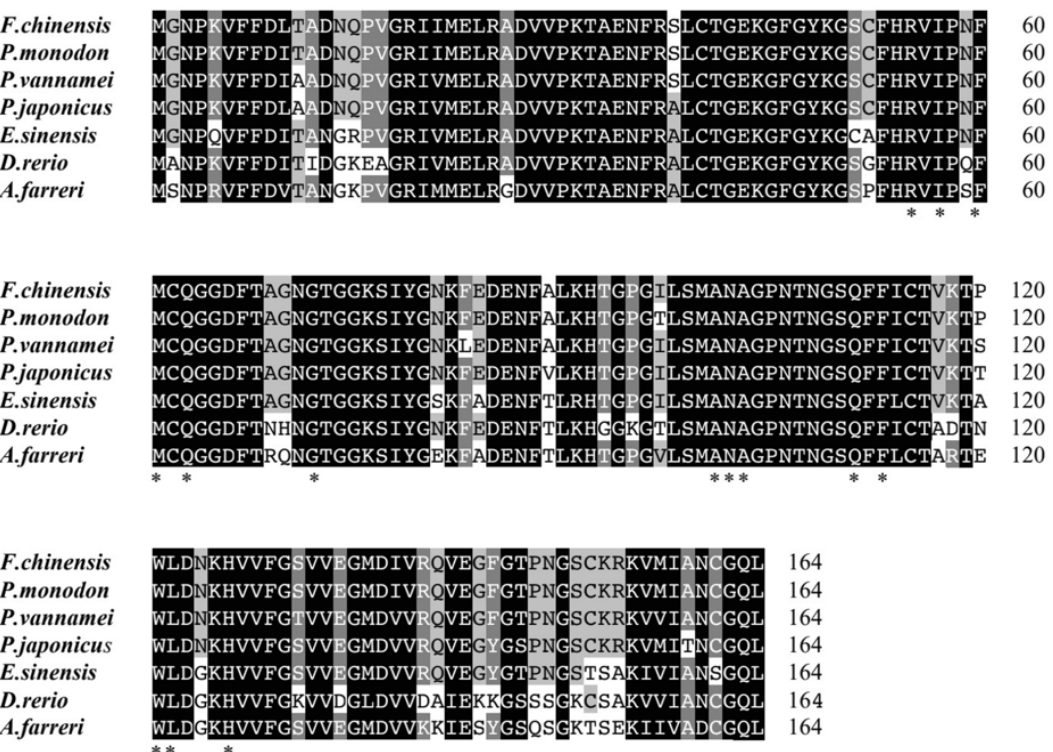
Fig. 2 Multiple alignment of Fc CypA with other CypAs deposited in GenBank. Thesame amino acid residues were shaded inblack and the similar amino acids wereshaded in grey. Gaps were indicated bydashes to improve the alignment. The sequences and their accession numbers are as follows: Fenneropenaeus chinensis (ANH58180.1), Penaeus monodon (AGS46493.1), Penaeus vannamei (ADY69343.1), Penaeus japonicus (XP_042880185.1),